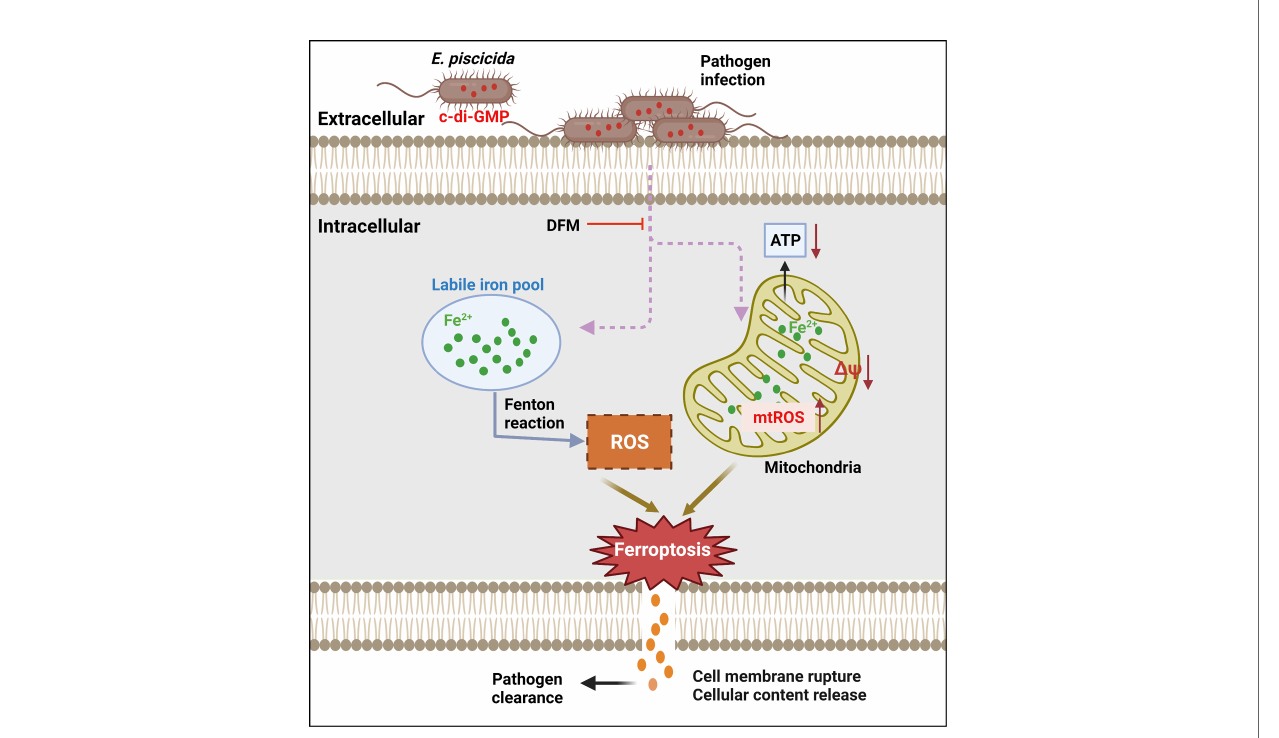
FIGURE 7 | Summary of proposed mechanism of bacterial c-di-GMP promoting non-canonical ferroptosis. Elevated c-di-GMP in E. piscicida promotes cellular labile iron accumulation resulting in decrease of mitochondrial potential and ATP production, and increase of mitochondrial and cytosolic ROS generation triggering a non- canonical ferroptosis which is independent of lipid peroxidation and could be inhibited by iron chelator DFM. The dysregulation of c-di-GMP in E. piscicida also attenuates its colonization and virulence in vivo